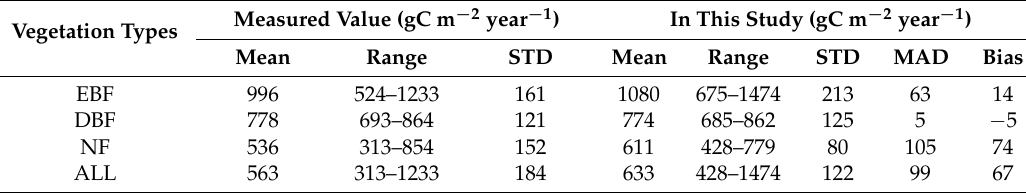
Figure 6. The relationships between estimated NPP and field-measured data ( N = 59). Table 3. Statistics of the estimated NPP performances at 59 field